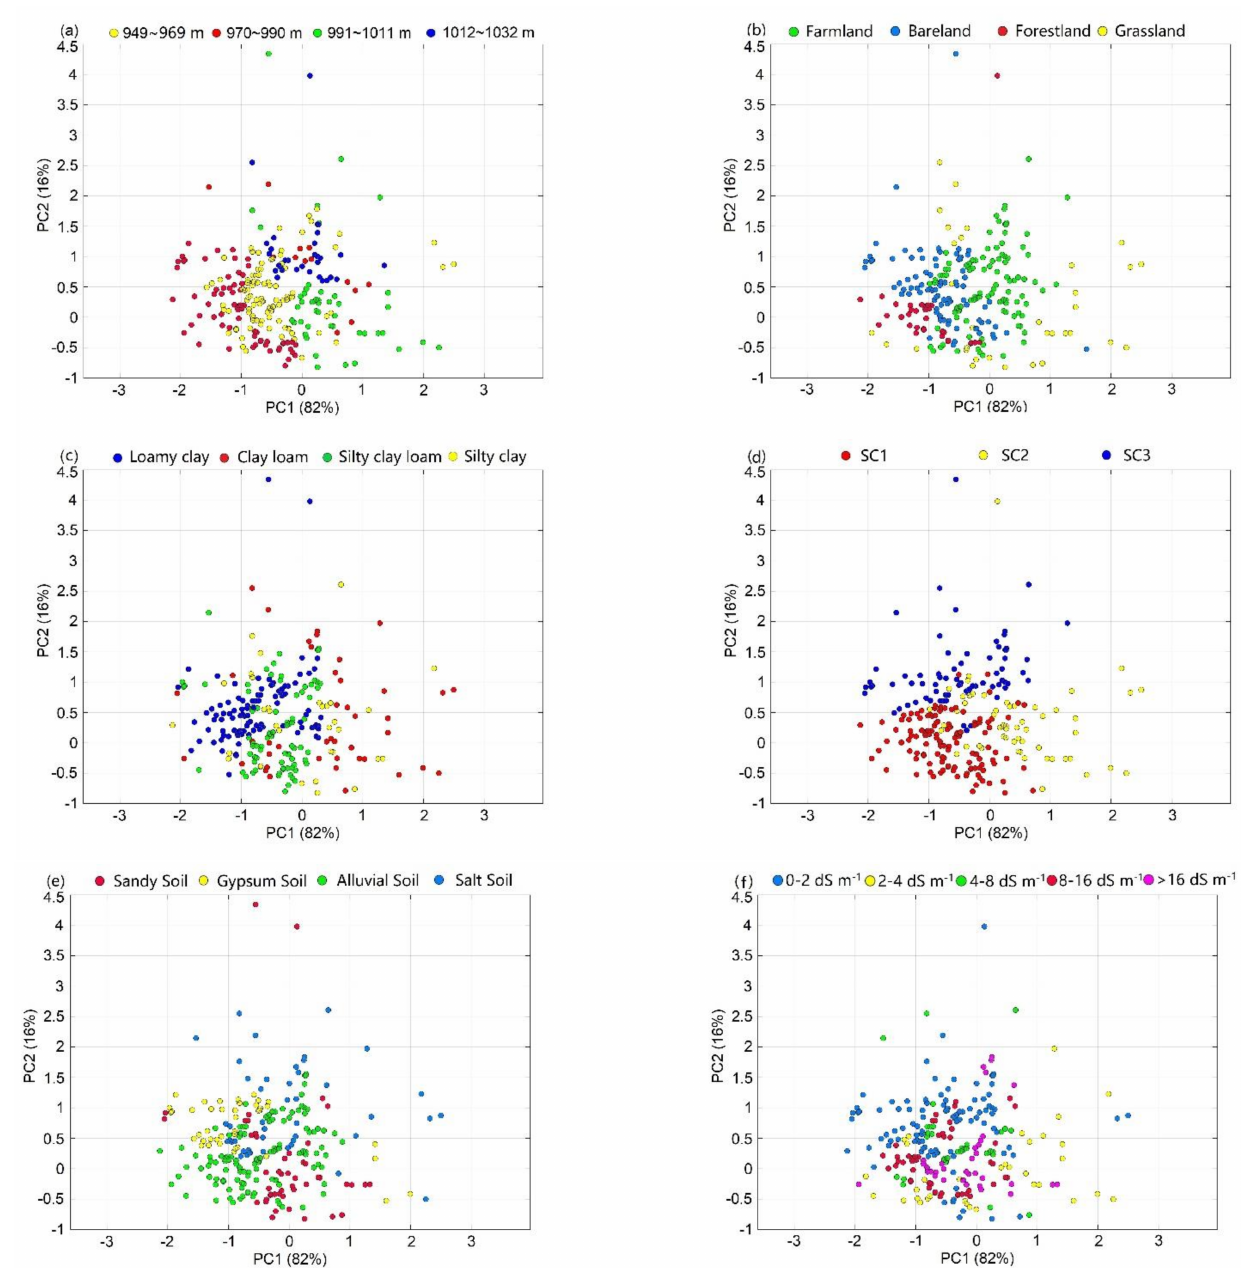
Figure 5. PCA results for each auxiliary variable; ( a ) DEM, ( b ) LULC, ( c ) soil texture, ( d ) spectral classification, ( e ) WRB, and ( f )